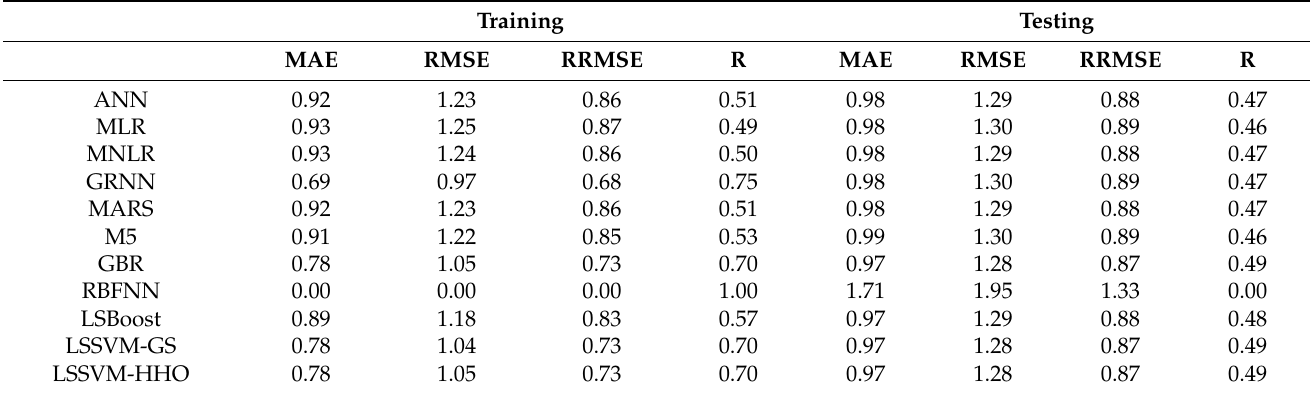
Table A2. Results of modeling WS with the base algorithms at the Sabzevar station.